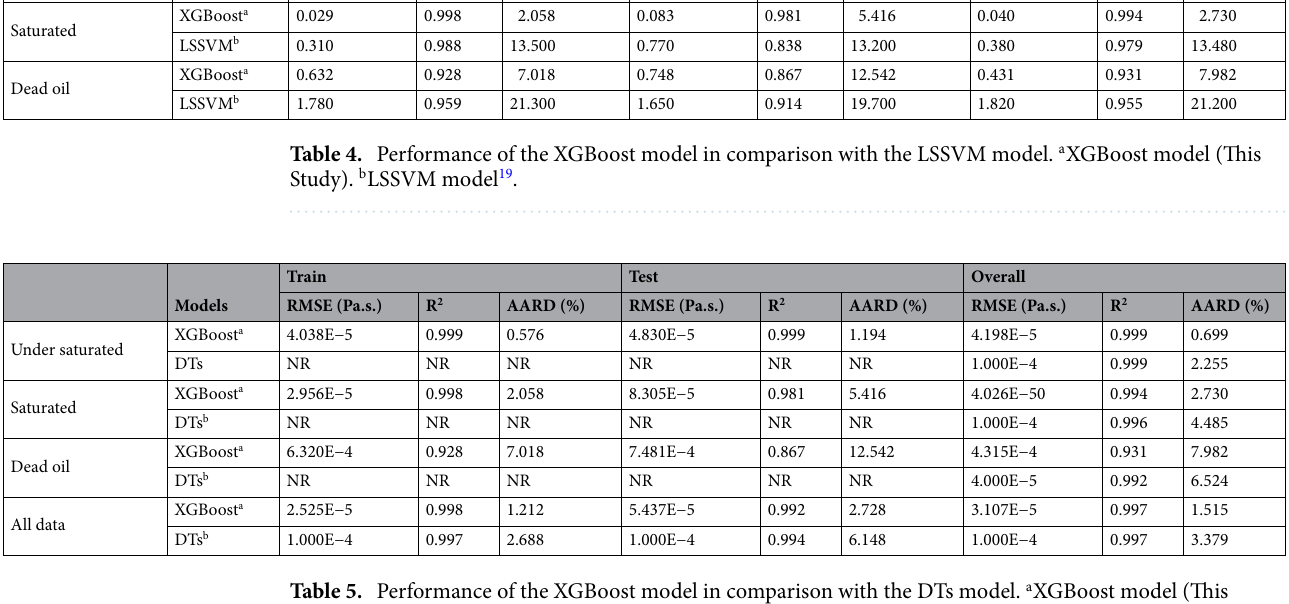
Table 5. Performance of the XGBoost model in comparison with the DTs model. a XGBoost model (This Study). b DTs model 20 . NR Not